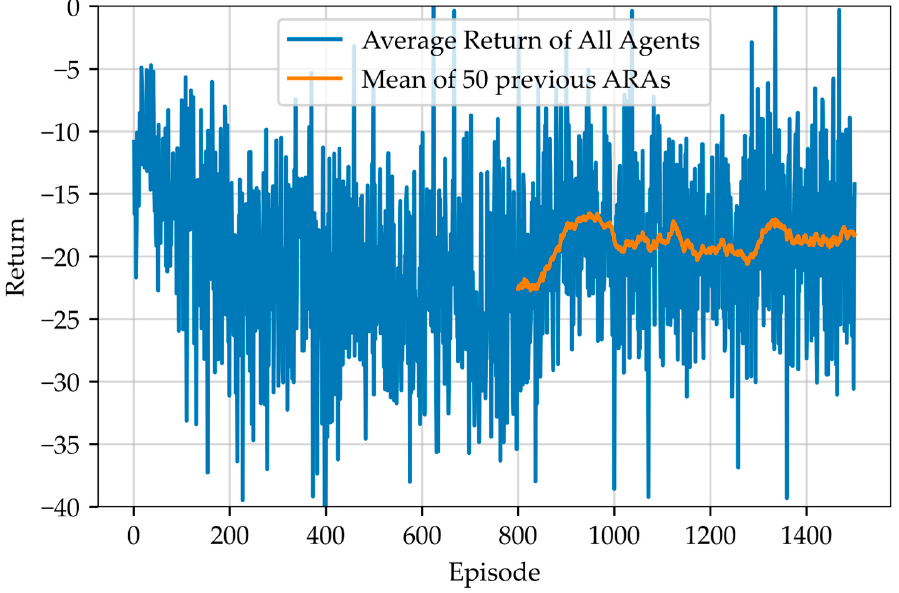
Figure 5. The ARA and MARA of Case I.